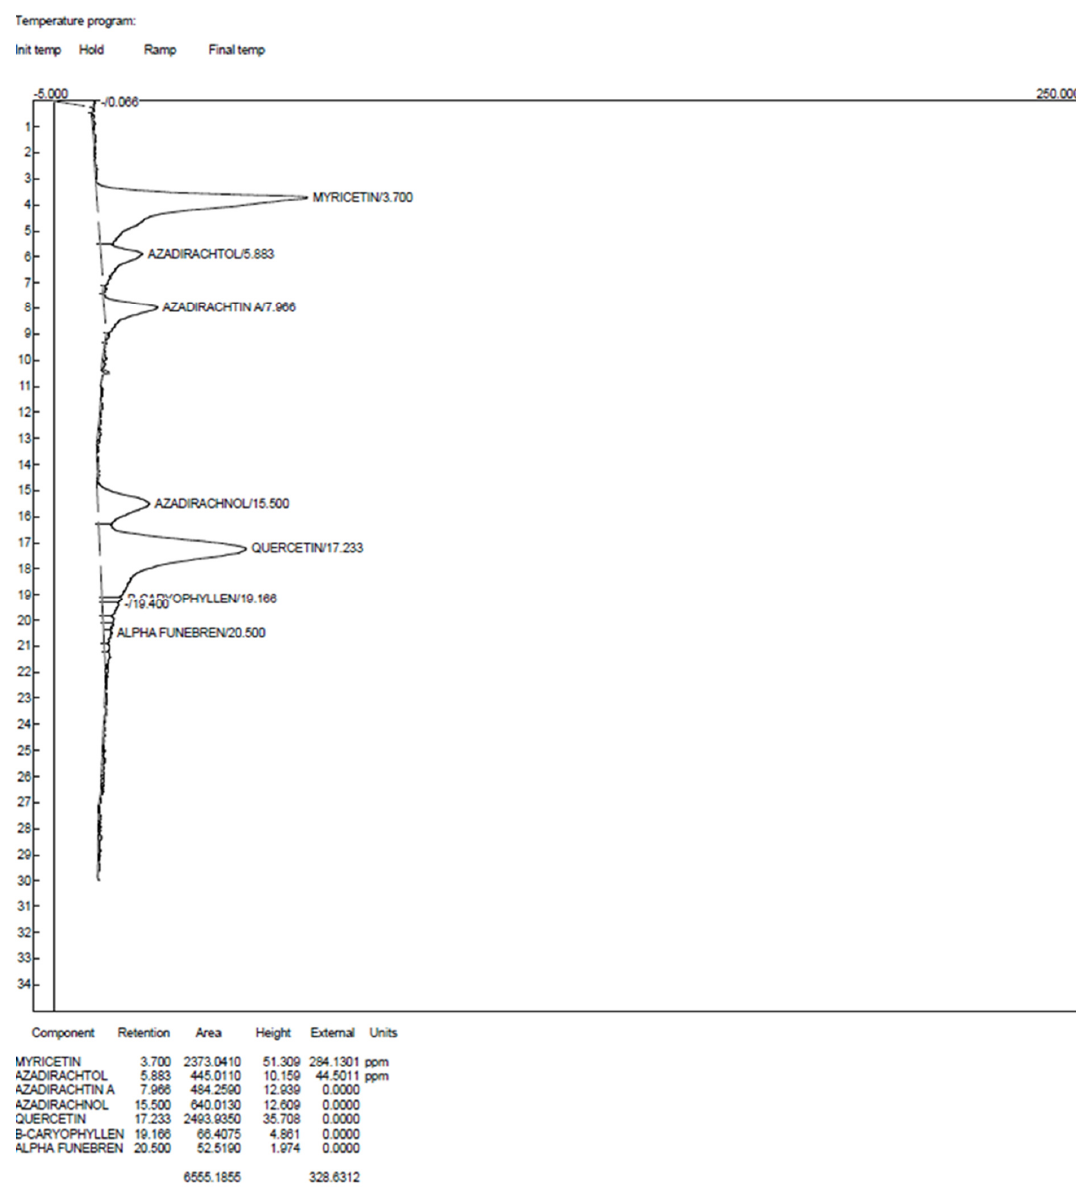
Figure 6. Chromatogram of hexane extract of A. indica